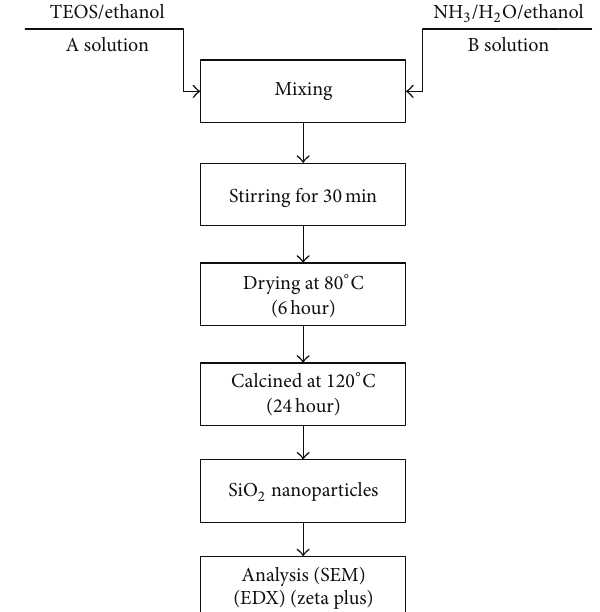
Figure1:ExperimentalprocedureforthesynthesisofSiO 2 nanopar- ticles using sol-gel method.